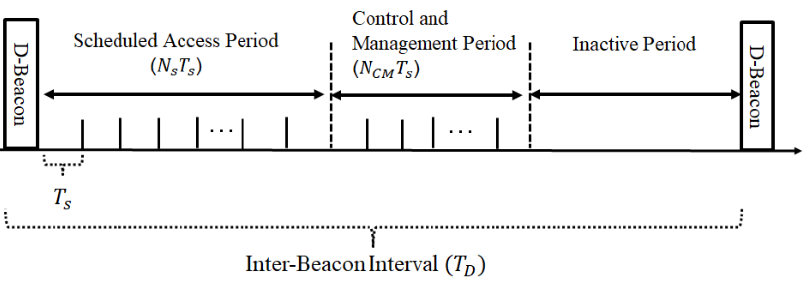
Figure 2. Access periods in the data channel (DCH).